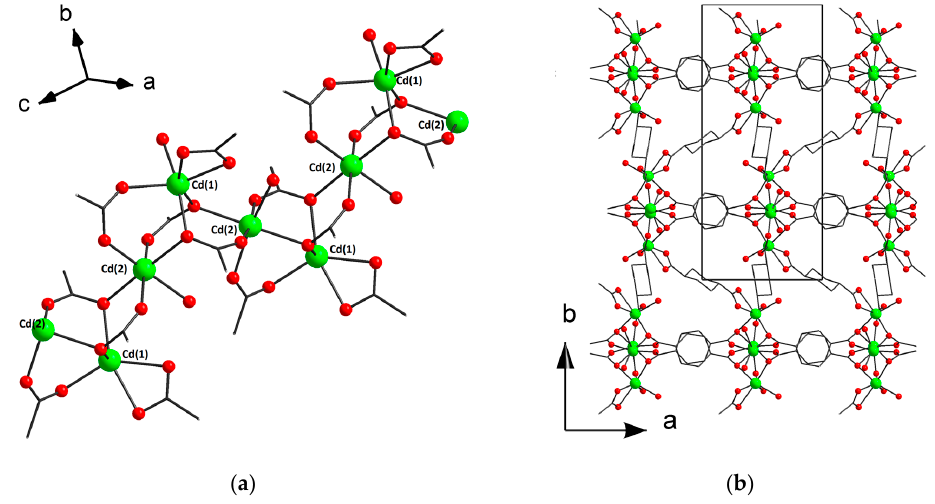
Figure 2. Fragment of polymeric chain ( a ) and 3D metal–organic framework ( b ) in 3 (CCDC 1973664). Hydrogen atoms and guest CH 3 CN molecules are omitted for